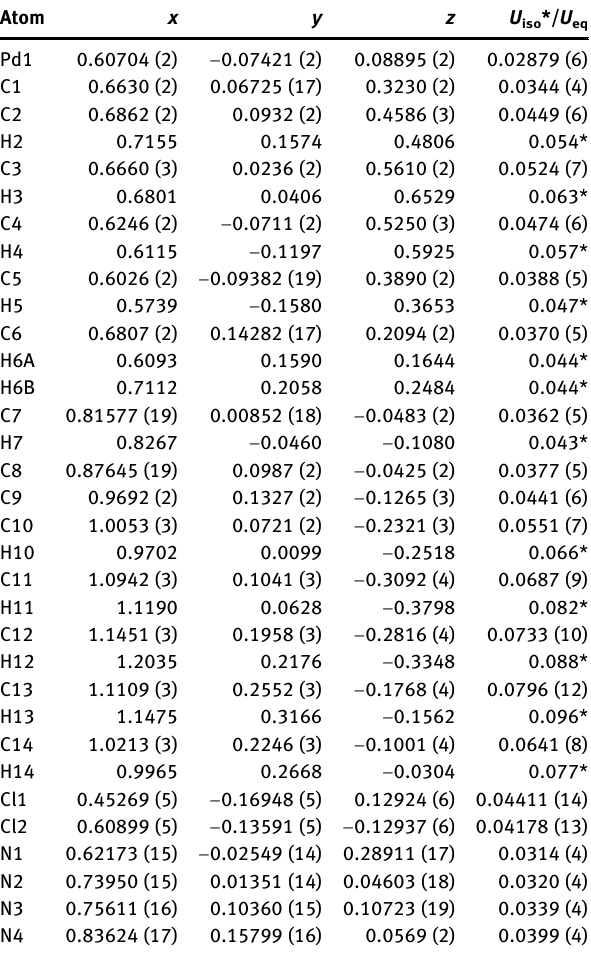
Table  : Fractional atomic coordinates and isotropic or equivalent isotropic displacement parameters (Å 